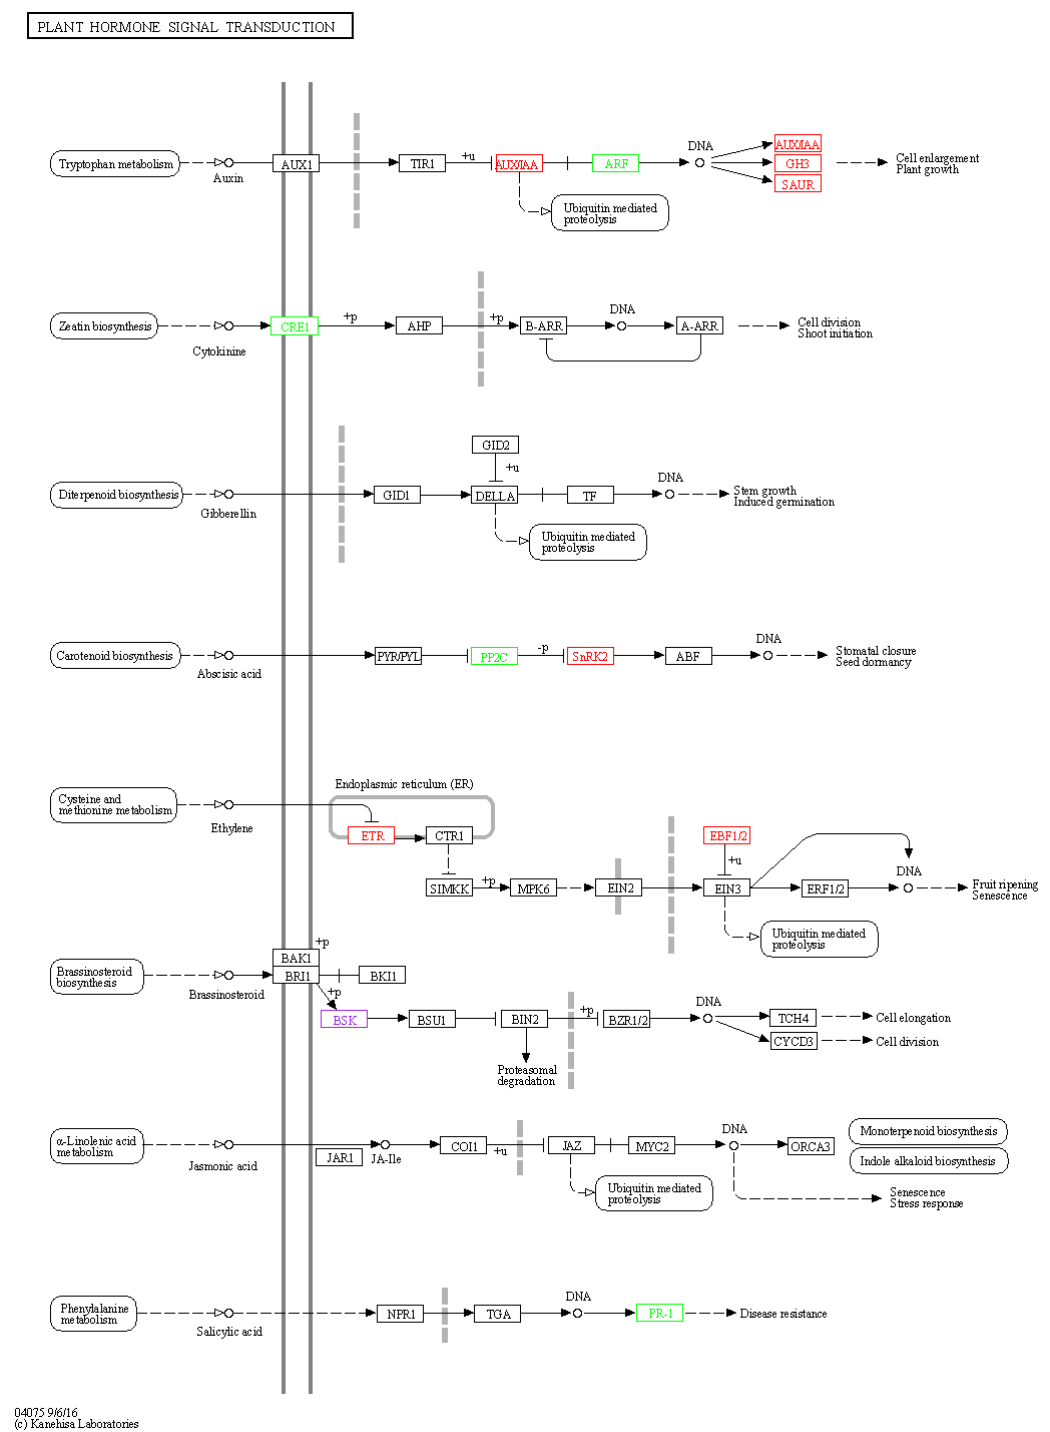
Figure 11. Influences of plant hormone signal transduction pathways under WL vs. RL in C. oleifera leaves. The red color represents up-regulated unigenes; the green color represents down-regulated unigenes; and the purple color represents containing both up-regulated unigenes and down-regulated unigenes.